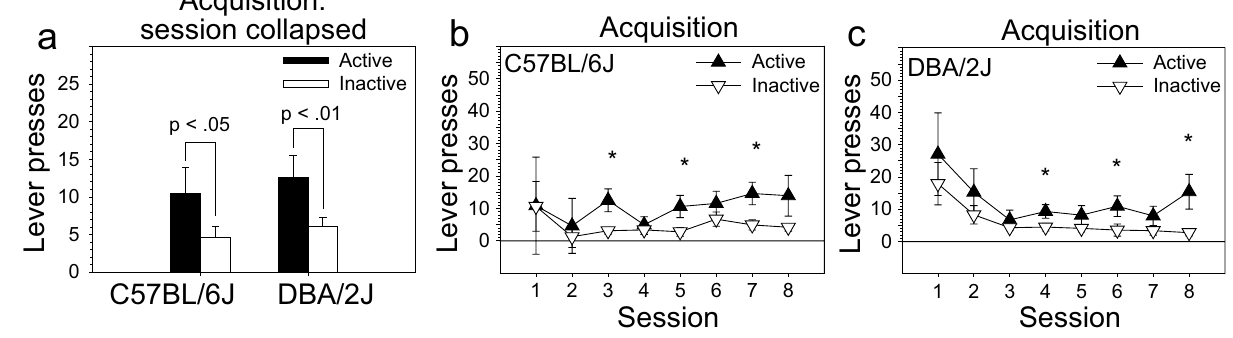
Figure 1. Acquisition of intravenous fentanyl self-administration in C57BL/6J and DBA/2J mice. Mice from both the C57BL/6J and DBA/2J strains pressed the active lever significantly more than the inactive lever on